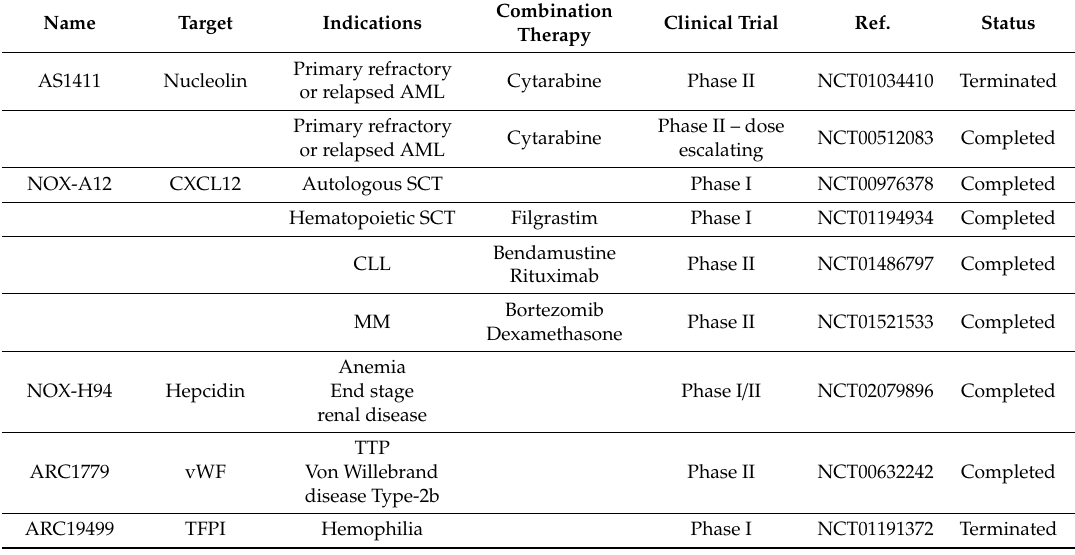
Table 3. Therapeutic aptamers for hematological